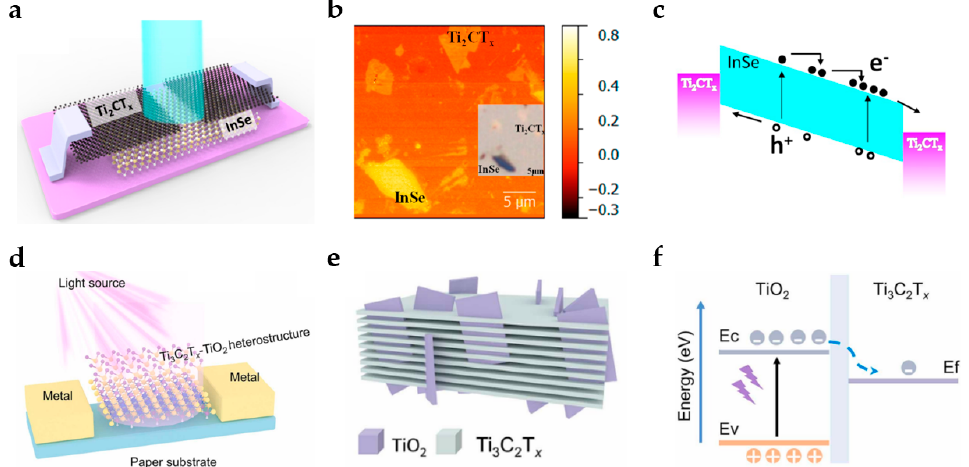
Figure 8. ( a ) Diagram of InSe/Ti 2 CT x PD. Ti 2 CT x is employed as the 2D electrode material. ( b ) Kelvin probe force microscopy potential mapping images showing InSe and Ti 2 CT x slices. The inset figure shows the corresponding optical microscope image. ( c ) Illustration of the avalanche effect in an InSe/Ti 2 CT x PD. (Reprinted with permission from ref. [90]. Copyright 2019 American Chemical Society Publications). Schematic diagram of ( d ) Ti 3 C 2 T x -TiO 2 PD and ( e ) 3D-networked Ti 3 C 2 T x - TiO 2 . ( f ) Schematic band alignments and carrier flow at Ti 3 C 2 T x -TiO 2 interfaces. (Reprinted with permission from ref. [91]. Copyright 2022 Elsevier Publications).